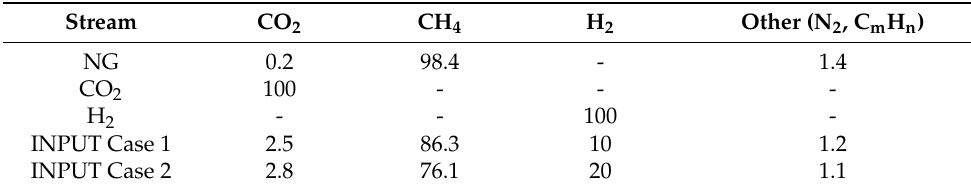
Table 5. Gas composition of process streams on injection side of the geo-methanation process (values in vol.-%